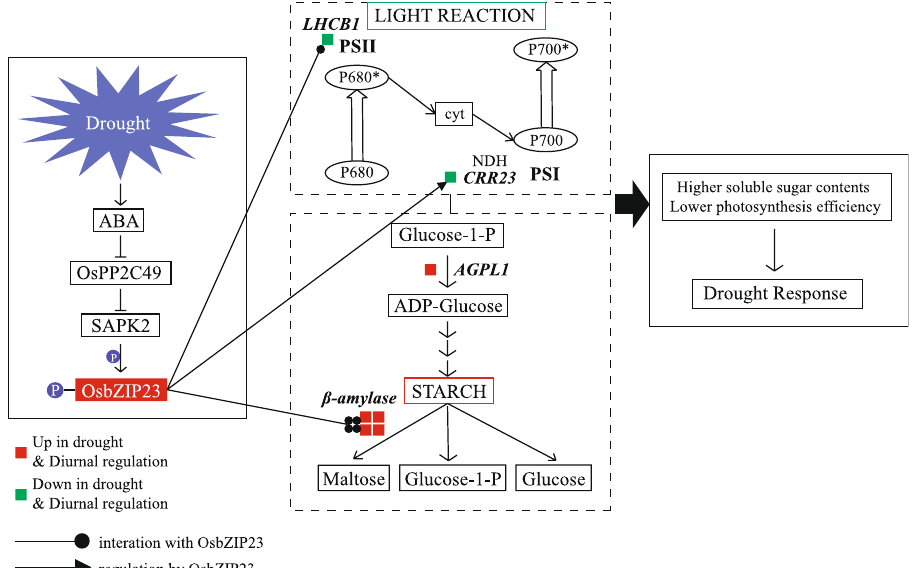
Figure 8. Suggested model to describe how drought-inducible OsbZIP23 regulates both light reactions and starch-sucrose pathway. Red boxes, genes showing diurnal expression pattern and up-regulated by drought; green boxes, diurnal genes down-regulated by drought. Genes encoding proteins interacting with OsbZIP23 are linked with circle-head lines; those encoding proteins regulated by bZIP23 are connected with triangle-head arrows. Pathways in solid-line rectangles were previously elucidated. Pathways bordered by rectangles with dotted lines include genes proposed here as part of crosstalk between diurnal expression and drought